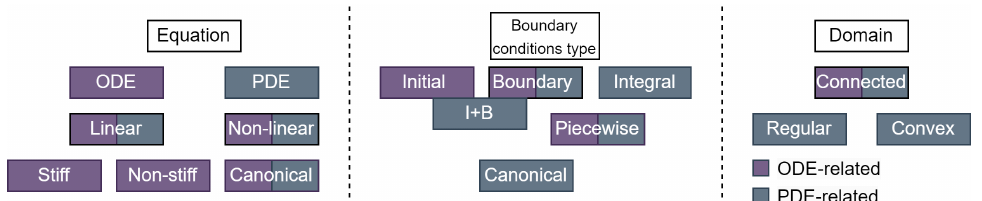
Figure 1. Rough classification of differential equation solvers. A classification that correspondingly may be applied to the equation is shown with ODE (violet), PDE (grey), or